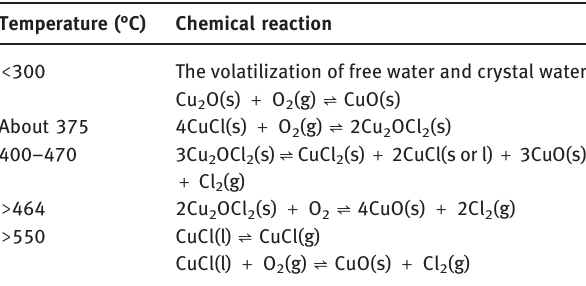
Table 3: Chemical reactions of CuCl at different temperature [20 – 22].